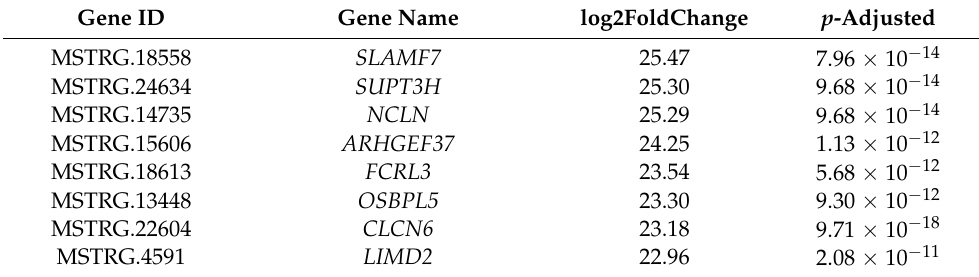
Figure 2. Heatmap visualization of the differentially expressed genes (DEGs) after RTX adminis- tration. Columns represent individual control (CTR) and RTX-treated (RTX) urinary bladder wall libraries; rows indicate gene symbols of DEGs. The z-score scale is applied for visualization expres- sion values (FPKM) of each biological replicate. The red color illustrates upregulated DEGs; the green color represents downregulated DEGs. Table 2. Significant upregulated differentially expressed genes (DEGs) between RTX-treated (RTX) and control (CTR)